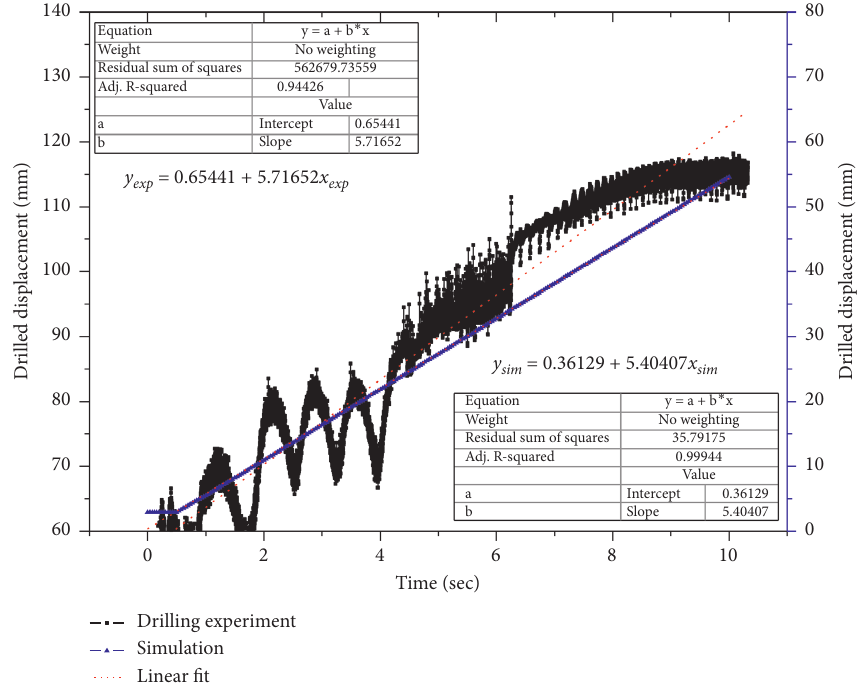
Figure 17: Comparison of predicted and measured drilling